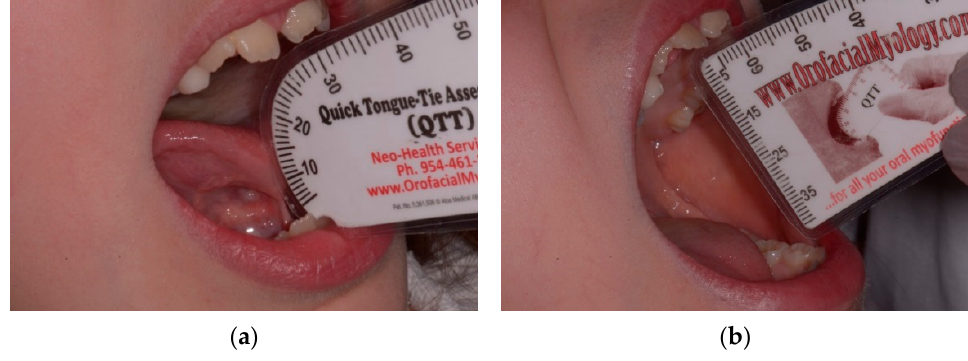
Figure 1. Quantitative variables at T0: ( a ) Kotlow; ( b ) MAB.